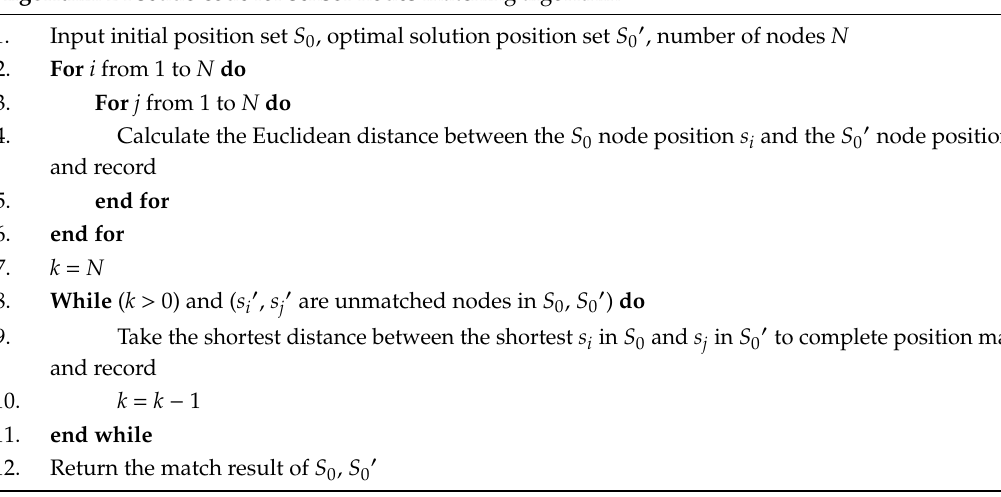
Algorithm 2 Pseudo code for sensor nodes matching